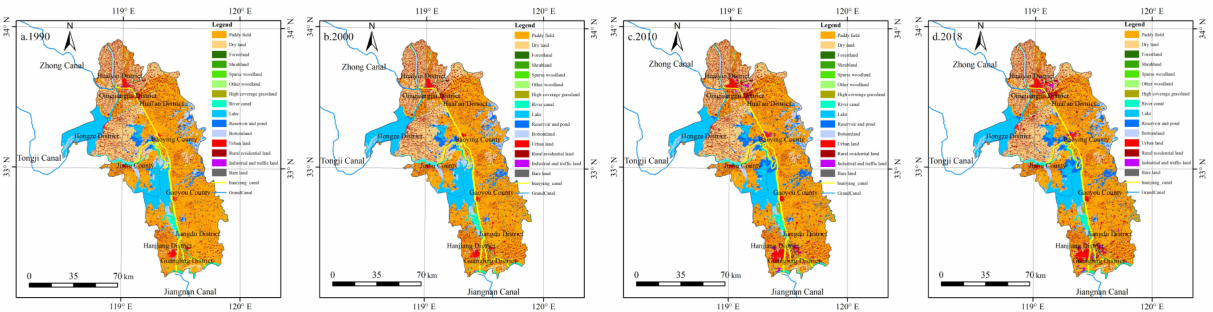
Figure 2. Spatial distribution of land-use types in the Huaiyang